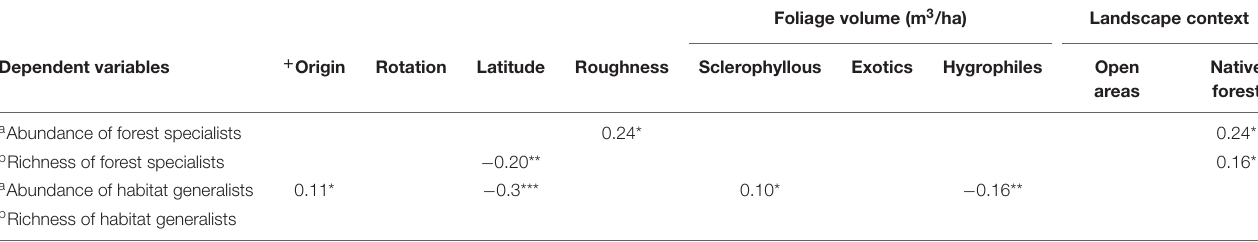
TABLE 2 | Coefficients of the best generalized linear models for the relative abundance and richness of birds in pine plantations with different origin and number of rotations.